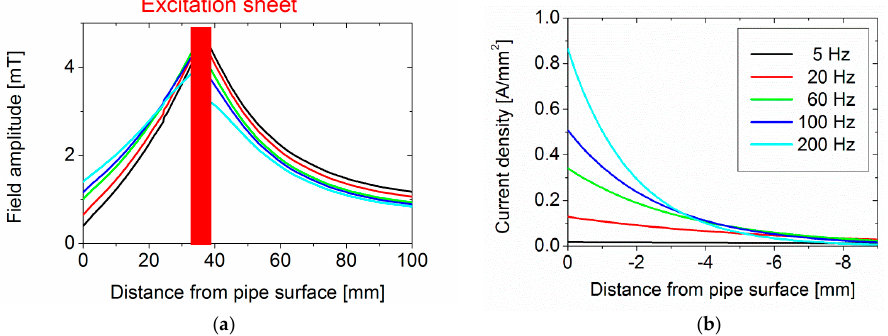
Figure 3. ( a ) Magnetic field magnitude in the r- Φ plane, through the centre of the excitation sheet versus distance from the pipe surface in the r direction at selected frequencies (5–200 Hz), calculated by the finite element method (FEM); ( b ) eddy current density in the pipe wall from inner radius to outer radius at selected frequencies (5–200 Hz), calculated analytically using the field values calculated by FEM.